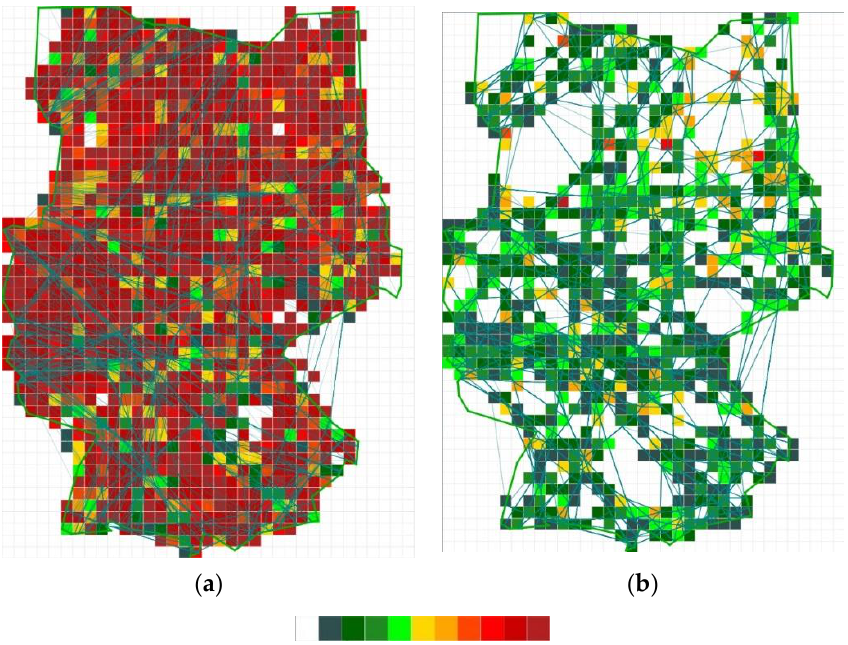
Figure 14. Structural complexity for intersections ( a ) and reduced main-flow network ( b ) for Scenario 1.